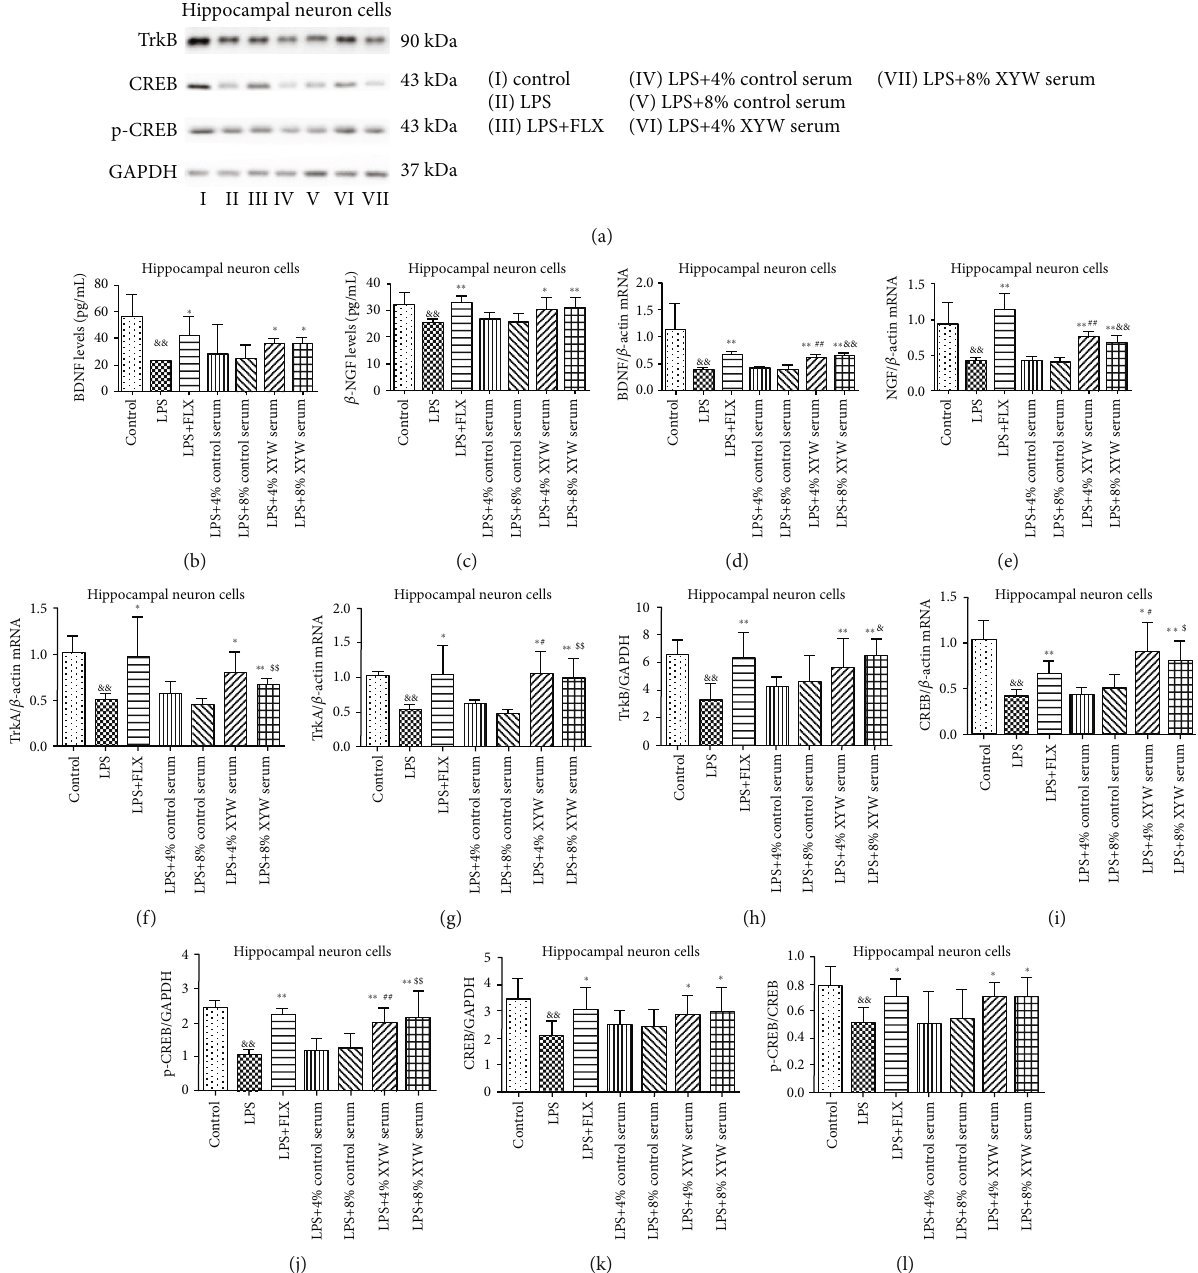
Figure 4: Xiaoyao Pills prevent LPS-induced reduction of neurotrophic factor. Representative blots of relative protein expression of TrkB, CREB, and p-CREB (a). Xiaoyao Pill serum (4% and 8%) improved the levels of BDNF (b) and β -NGF (c) in supernatant and increased the transcription level of BDNF (d), NGF (e), TrkB (f), TrkA (g), and CREB (i) and the translation levels of TrkB (h), CREB (k), and p- CREB (j) in cell lysate, as well as the ratio of p-CREB/CREB (l) higher than the LPS group. The results were expressed as the mean ± SD ( n = 5 ‐ 6 ). && p < 0 : 01 compared to the control group. ∗ p < 0 : 05 and ∗∗ p < 0 : 01 compared to the LPS group. ## p < 0 : 05 and ## p < 0 : 01 compared to the LPS+4% control serum group. $ p < 0 : 01 and $$ p < 0 : 01 compared to the LPS+8% control serum